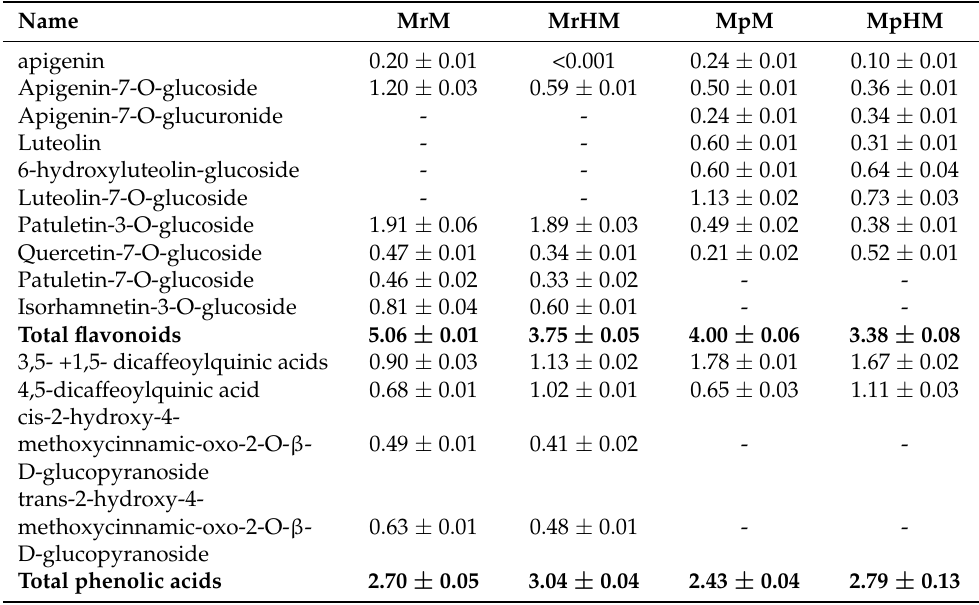
Table 3. Amounts of flavonoids and phenolics in the polar (MeOH and MeOH 50%) extracts of M. pubescens (Mp) and M. recutita (Mr) flowers ( n = 3). Results expressed as % w / w